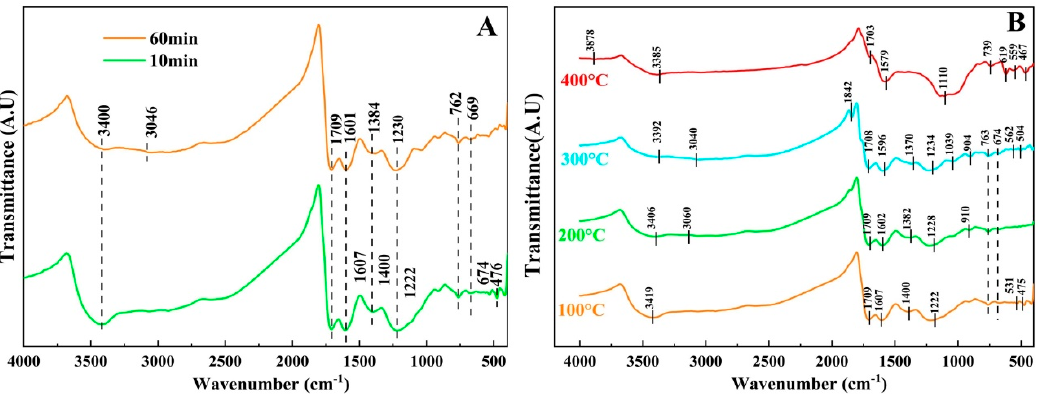
Figure 6. FTIR analysis of MHA at different heating times ( A ) and heating temperatures ( B ).